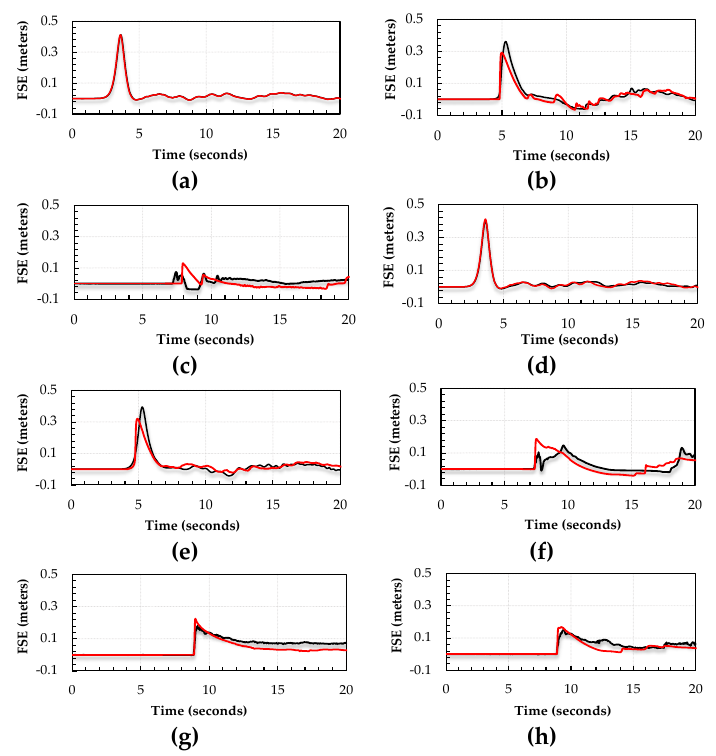
Figure 3. Comparison of free surface elevation (FSE) results: ( a ) X = 7.5 m and Y = 0.0 m at Gage 1; ( b ) X = 13.0 m and Y = 0.0 m at Gage 2; ( c ) X = 21.0 m and Y = 0.0 m at Gage 3; ( d ) X = 7.5 m and Y = 5.0 m at Gage 4; ( e ) X = 13.0 m and Y = 5.0 m at Gage 5; ( f ) X = 21.0 m and Y = 5.0 m at Gage 6; ( g ) X = 25.0 m and Y = 0.0 m at Gage 7; ( h ) X = 25.0 m and Y = 5.0 m at Gage 8. Black line represents benchmark data, red line represents numerical results.